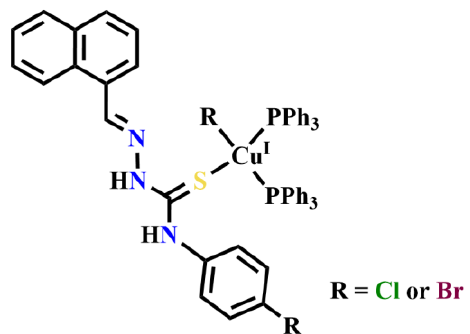
Figure 23. A pair of Cu(I) complexes of the mono-coordinated naphthylhydrazone by S atoms